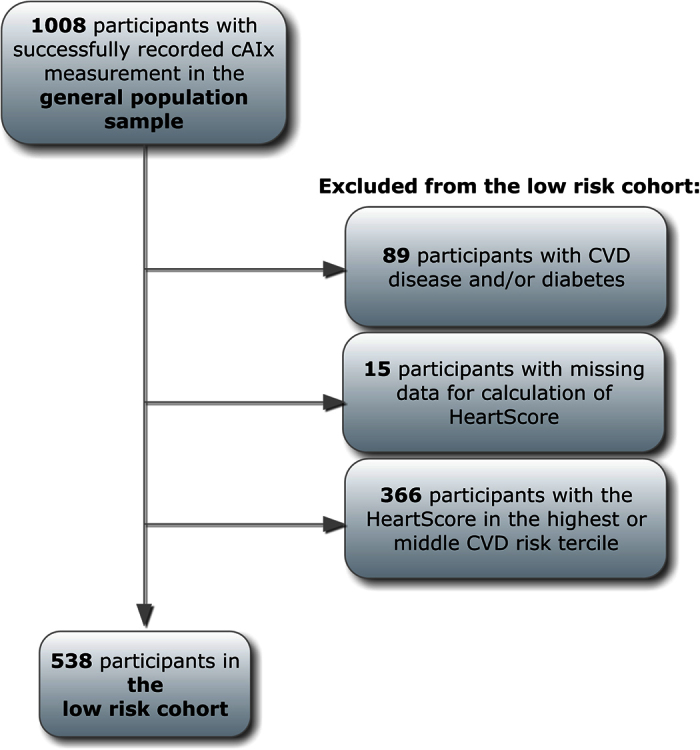
Study flow chart.